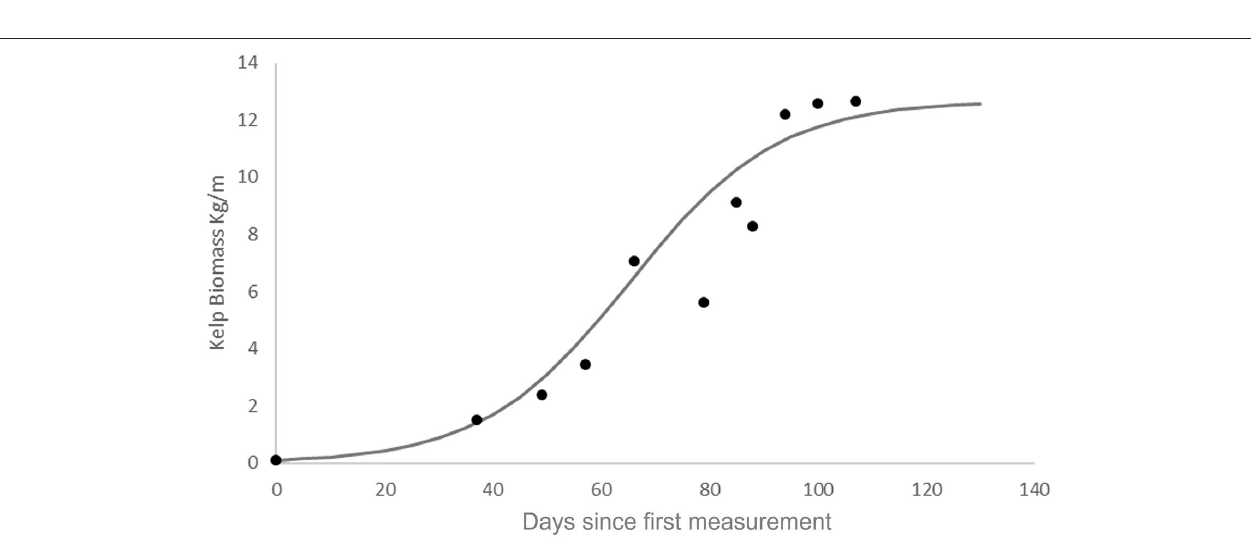
FIGURE 3 | (A) The components of the farm fit into fish totes loaded in a standard pickup truck. (B) The gear was loaded on a 10m landing craft research vessel. Note that only one of the two anchor assemblies are shown. (C) In February, the kelp was growing on the intact system. (D) Growth continued and in April, biomass was estimated at 5.37 kg/m and (E) harvested at 12.67 kg/m on 22-May-2019.